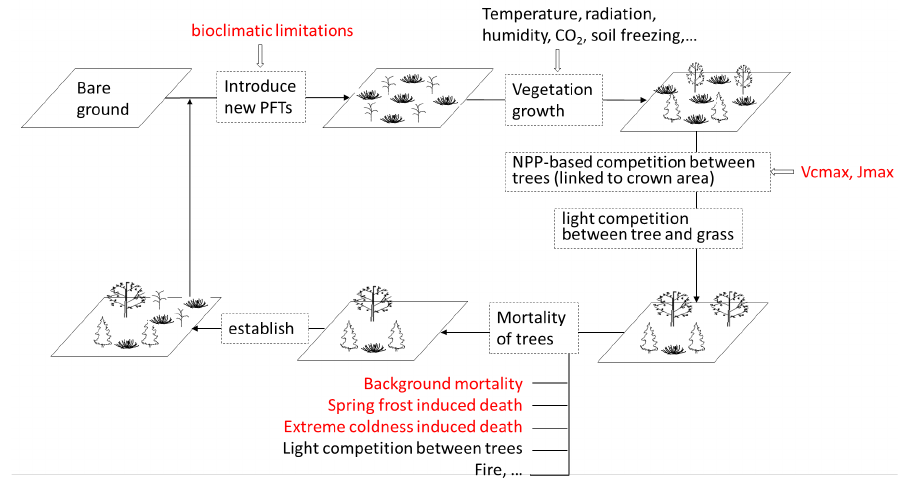
Figure 1. Schematic of ORCHIDEE vegetation dynamics module (ORC-VD). The modifications in this study are marked red.